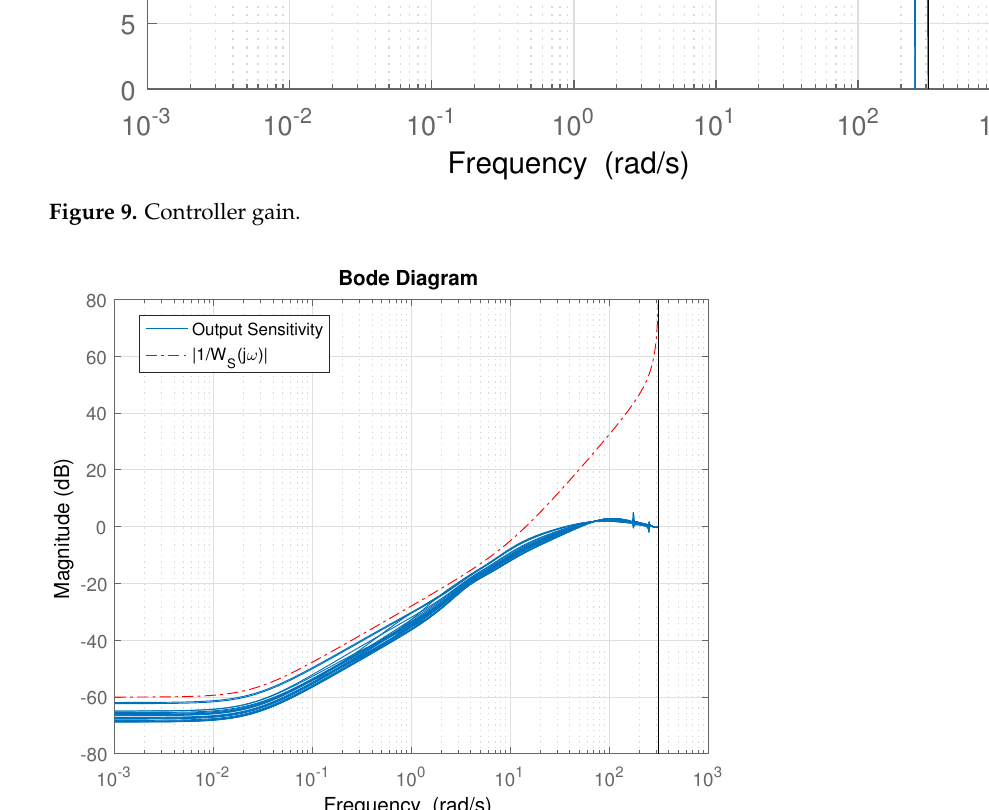
Figure 10. Output sensitivity function compared with its inverse weighting